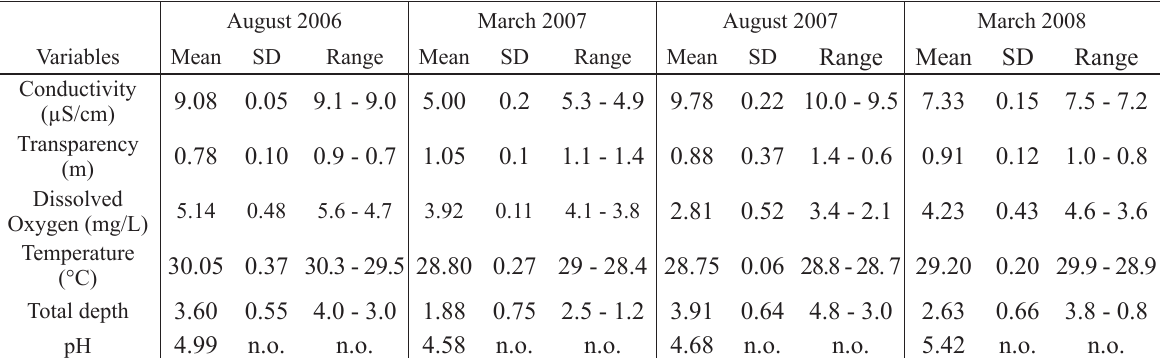
Figure 2 - Hydrological quotas (cm) of the Negro River fl oodplain during two consecutive years. (*) Indicates fl ooding period and (**) indicates receding water period. Source: Brazil’s National Water Agency (ANA). Physical and chemical variables from the Arrombado lake during receding (August 2006 and 2007) and fl ooding (March 2007 and 2008) periods. (n.o.) = Values not obtained. SD= standard deviation. Means were calculated using the values of the four sampling